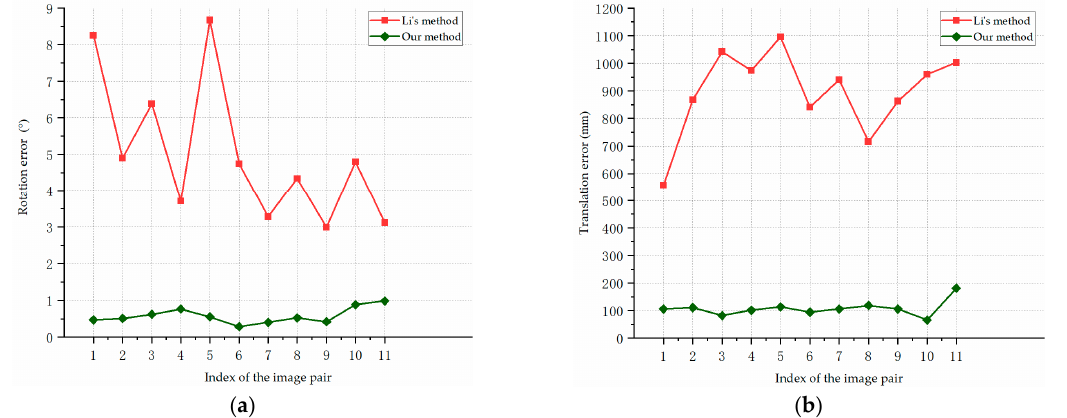
Figure 15. Pose estimation errors on the synthetic images of Cessna model in Scene 3: ( a ) rotation errors; ( b ) translation errors.